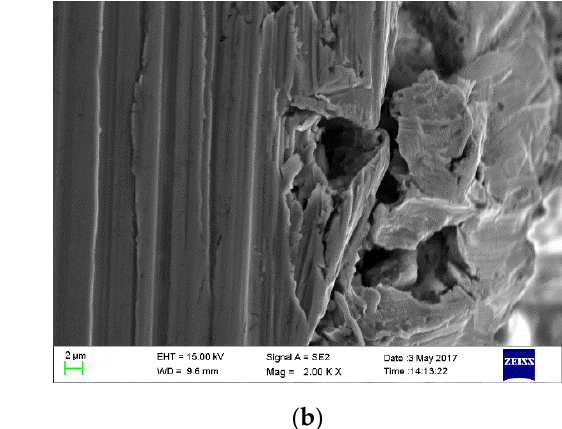
Table 4. Statistics of micro-cracks in the KMN-I vibration fatigue specimens.